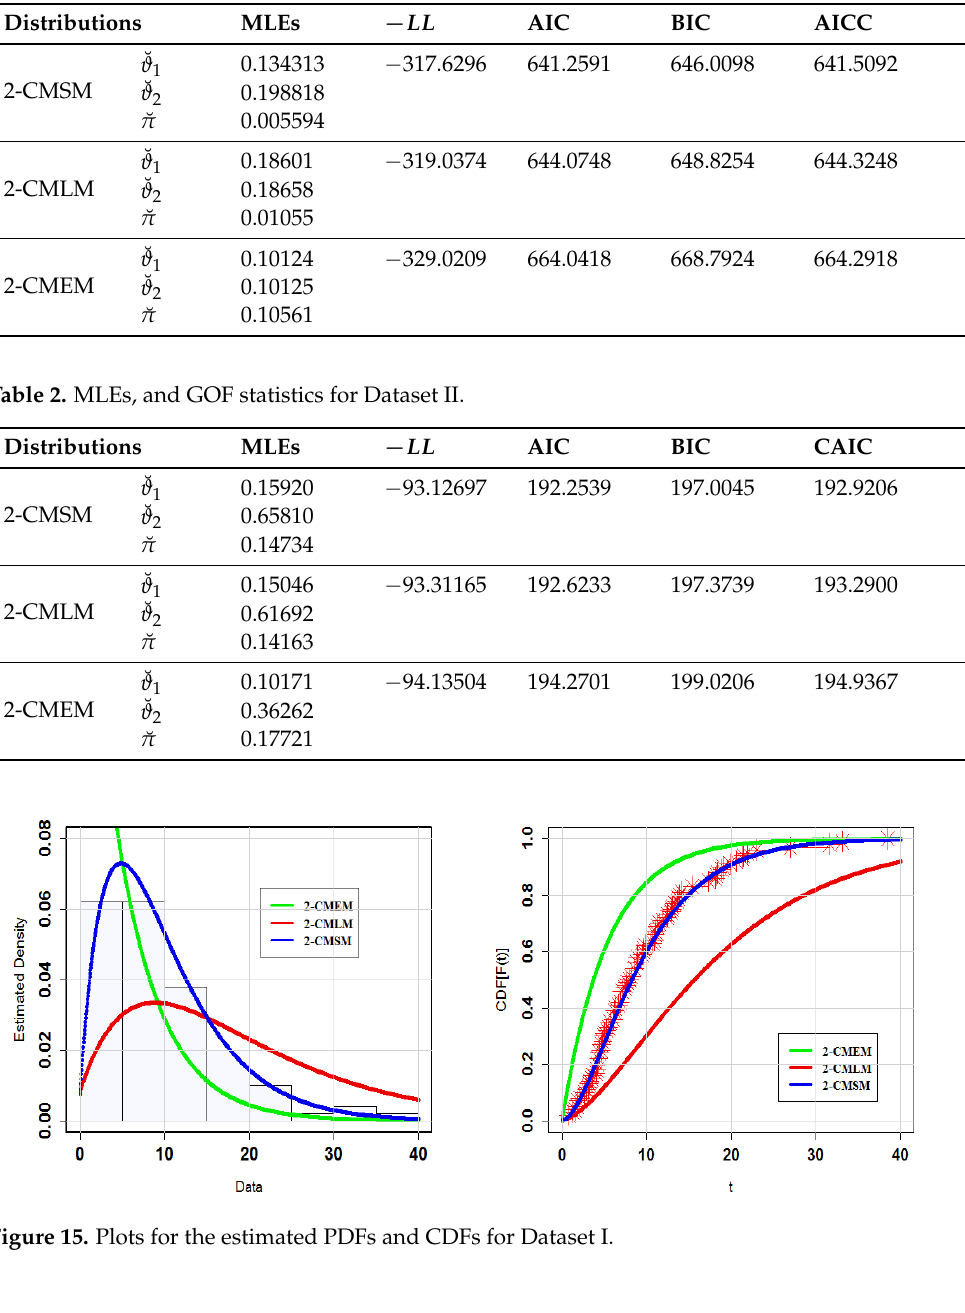
Fig. 16. Plots for the estimated PDFs and CDFs for Dataset II. 26